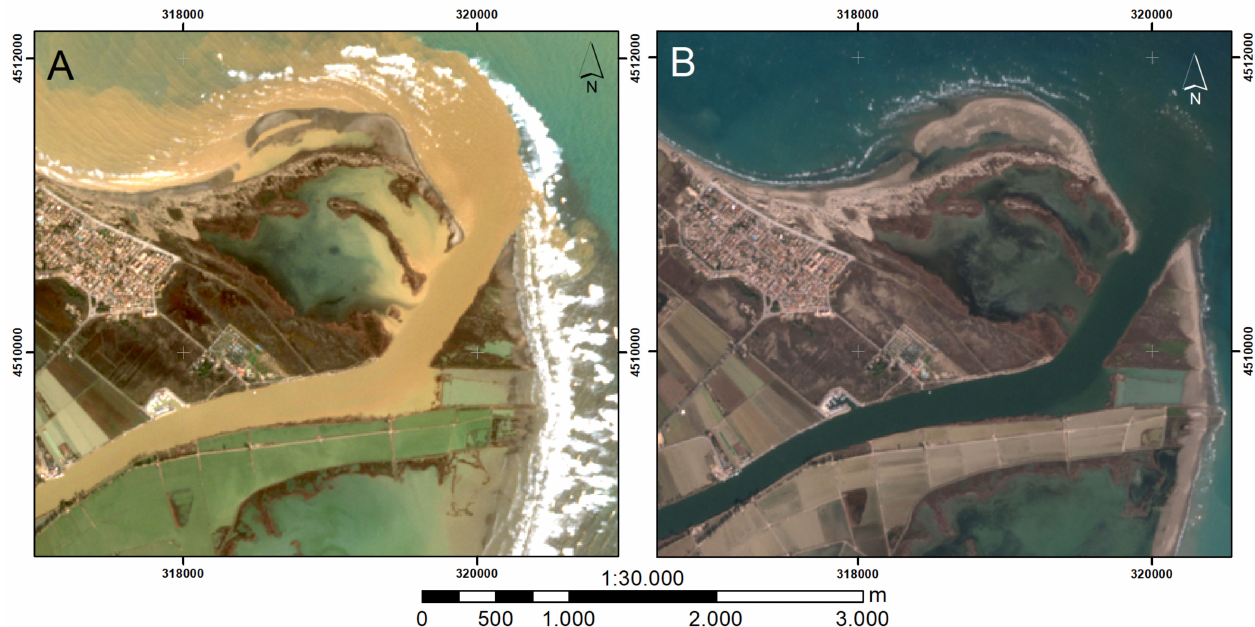
Figure 4. Images of Ebro River mouth. ( A ) Sentinel image of 23 January 2020 during storm Gloria. ( B ) Sentinel image of 17 January 2021 after storm Filomena. Reproduced from https://scihub.copernicus.eu/dhus/#/home (accessed on 27 January